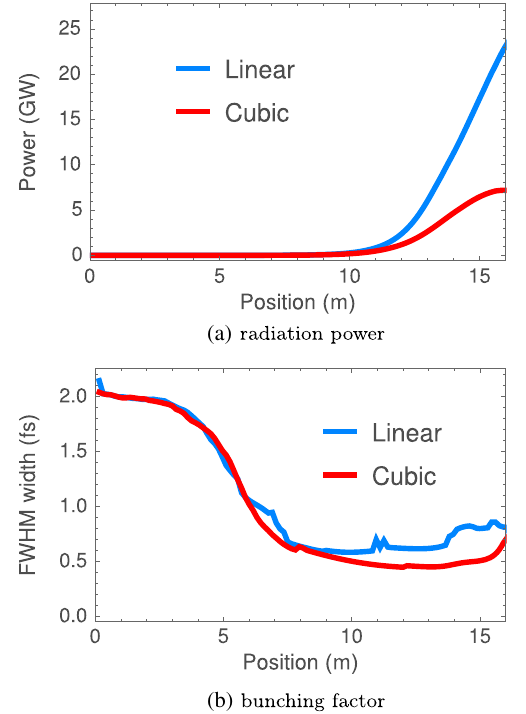
FIG. 8. Shot-averaged radiation power and bunching factor along the undulator for the drive beam of Fig. 7 (the average involves ten SASE shots). A power reduction/pulse shortening effect due to nonlinear chirp is evident in the high-gain stage of the linear region. The output radiation FWHM is about a third of the bunch length of the electron